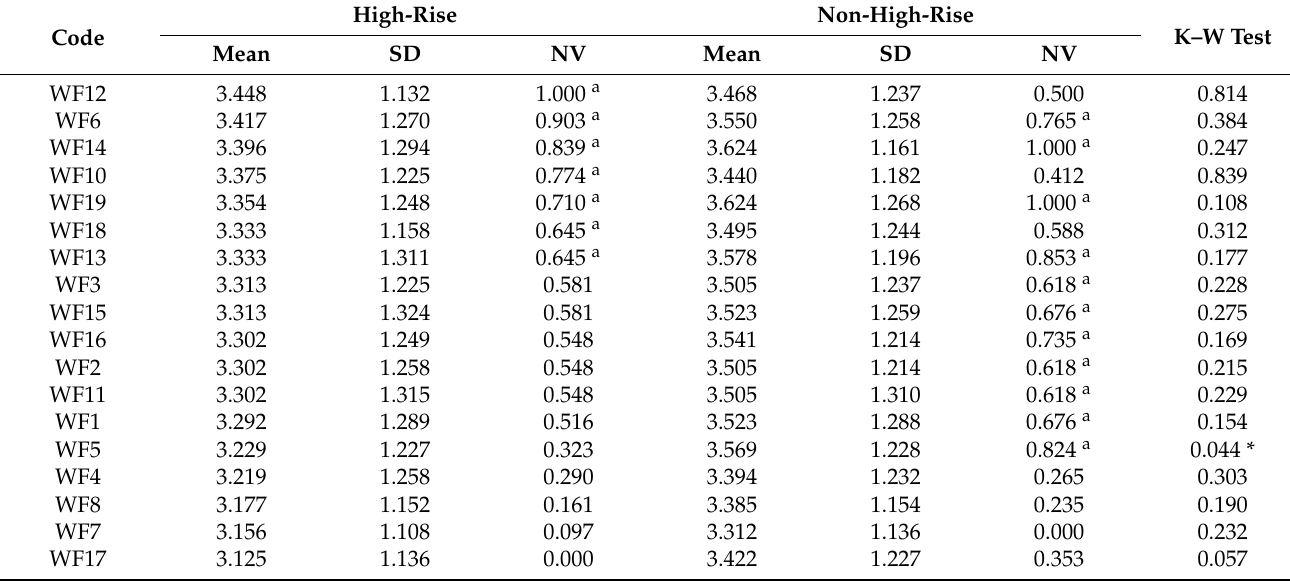
Table 4. Results of mean ranking analysis and Kruskal–Wallis test according to project types.